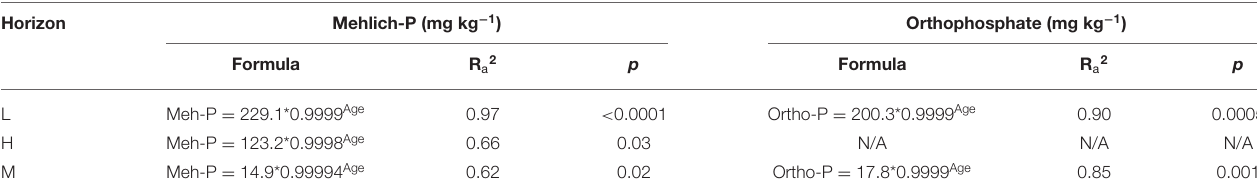
TABLE 5 | Mehlich phosphorus (P) and orthophosphate exponential decay formulas for the litter (L), and select humified organic (H), and mineral (M) horizons with adjusted R 2 (R a2 ) and p -value (p).